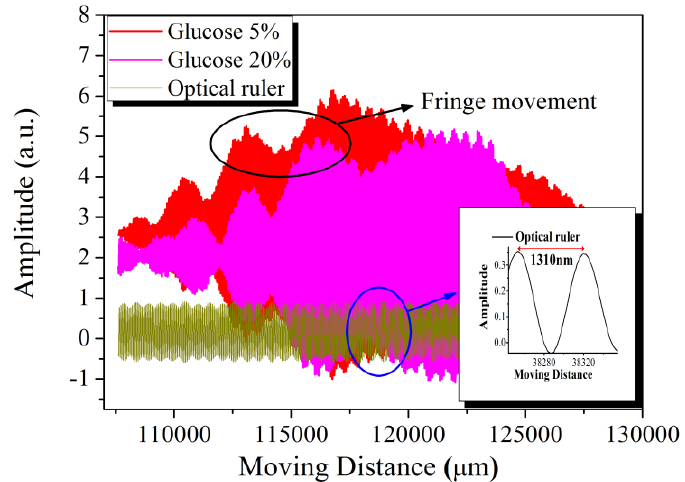
Figure 8. The relative movement distance between